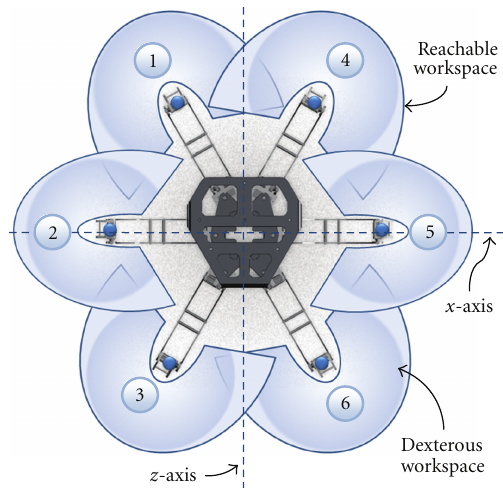
Figure 3: Working envelopes of robot